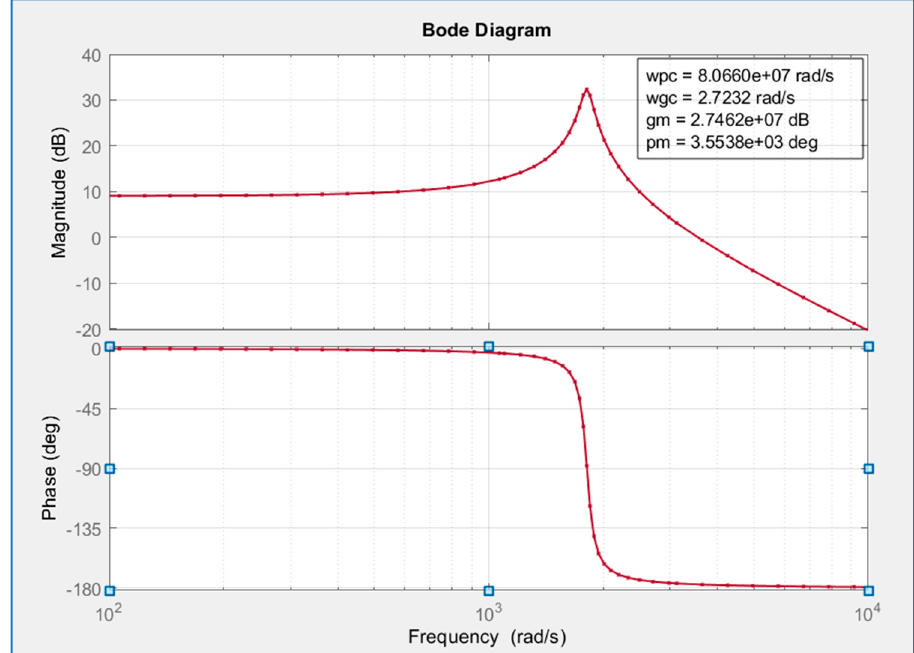
Figure 5. Bode plot of the super-lift Luo converter.